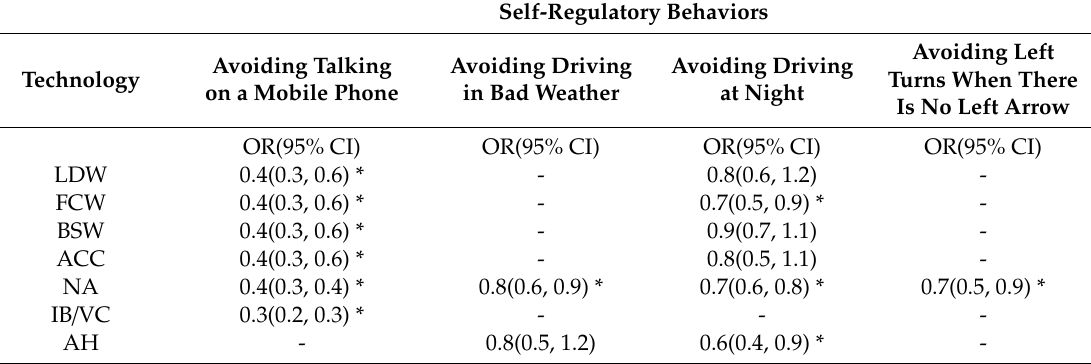
Table 4. Unadjusted Odds Ratios (ORs) and 95% Confidence Intervals (CIs) of Self-Regulatory Behaviors with Respect to In-Vehicle Technology